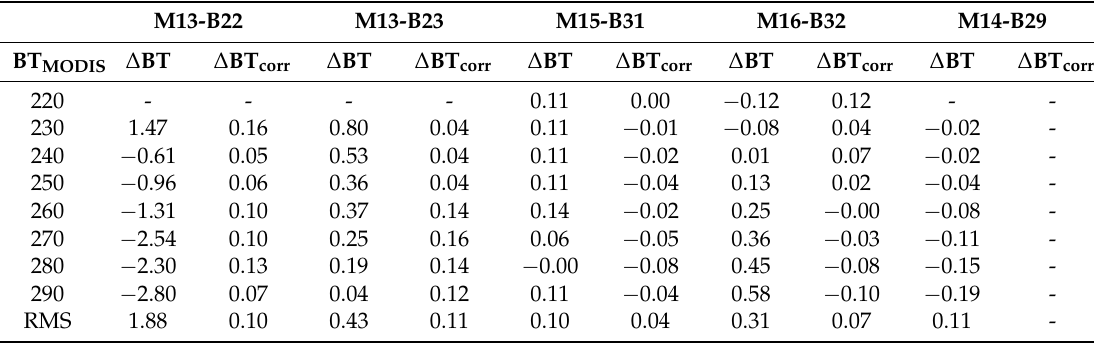
Table 2. Difference in brightness temperature without/with RSR correction from AIRS measurements (unit: K; RMS: root-mean-square of the bias).